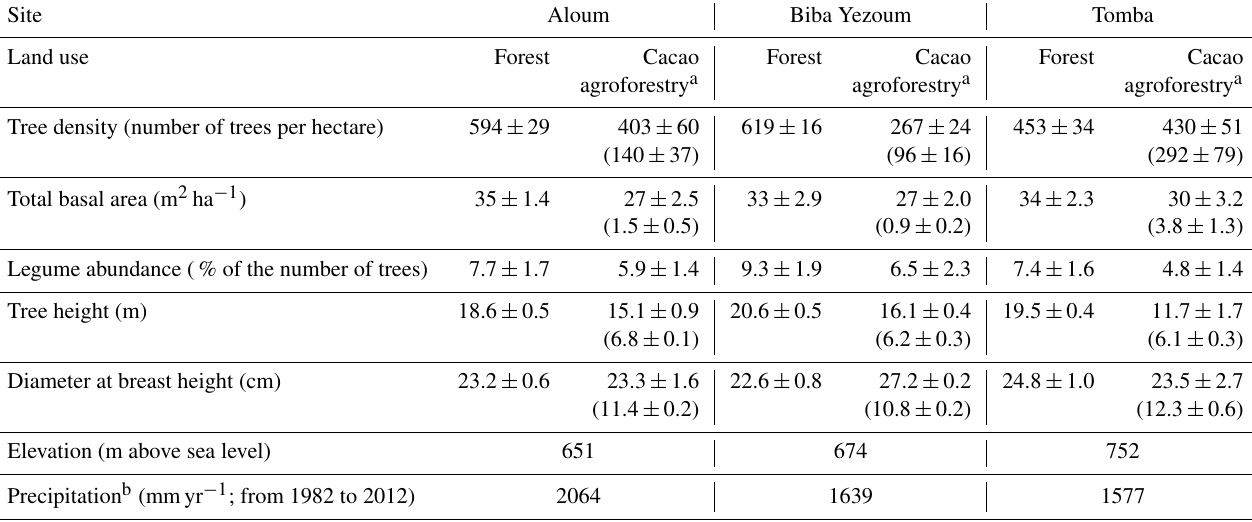
Table A1. Vegetation and site characteristics of the study sites on highly weathered soils in the Congo Basin, Cameroon. All vegetation characteristics were determined from trees with ≥ 10cm diameter at breast height in both forest and cacao